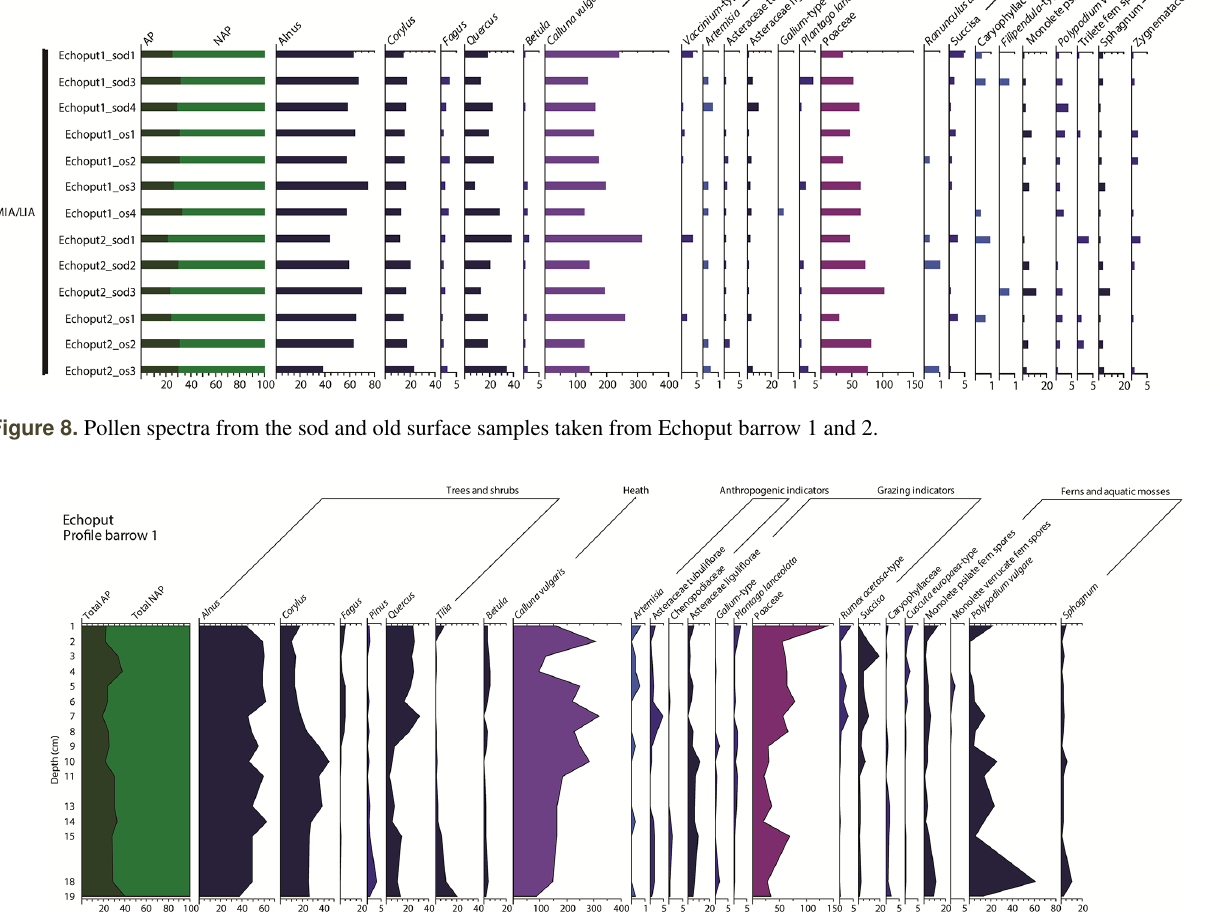
Figure 9. Pollen diagrams derived from the series of samples taken from underneath Echoput barrow